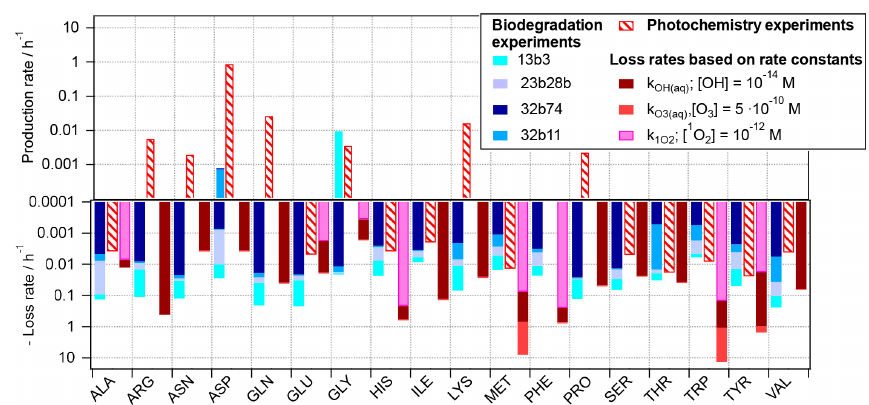
Figure 3. Reaction rates for 18 amino acids as observed based on experiments in the present study, scaled to atmospheric conditions (Eqs. 2 and 3) and rates for loss reactions by OH(aq), O 3 (aq), and 1 O 2 (aq) (Eq.